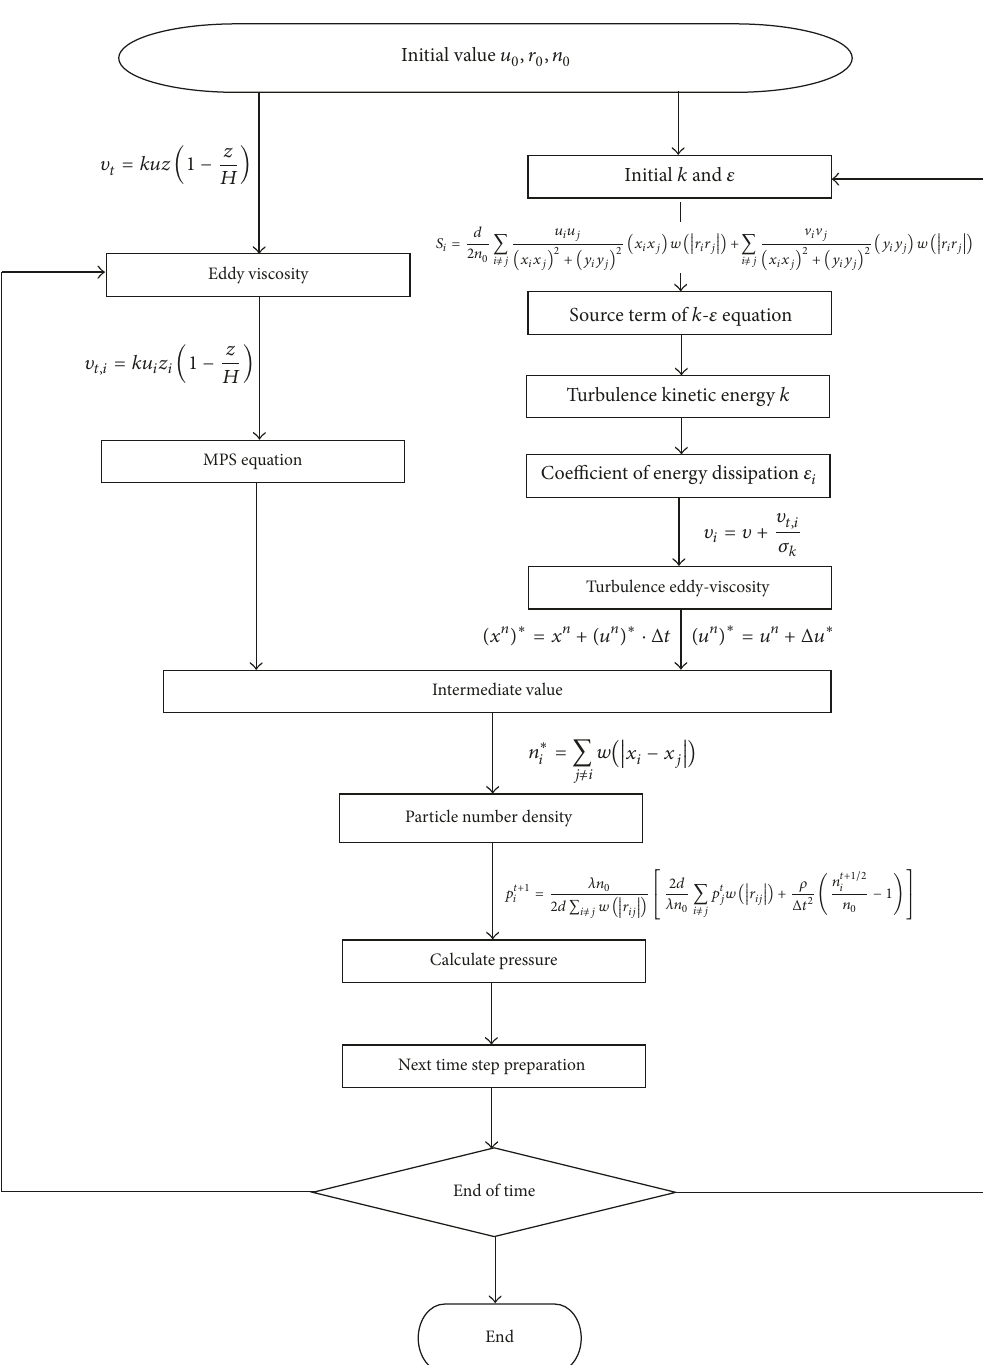
Figure 1: MPS realization process of MPS method considering turbulence